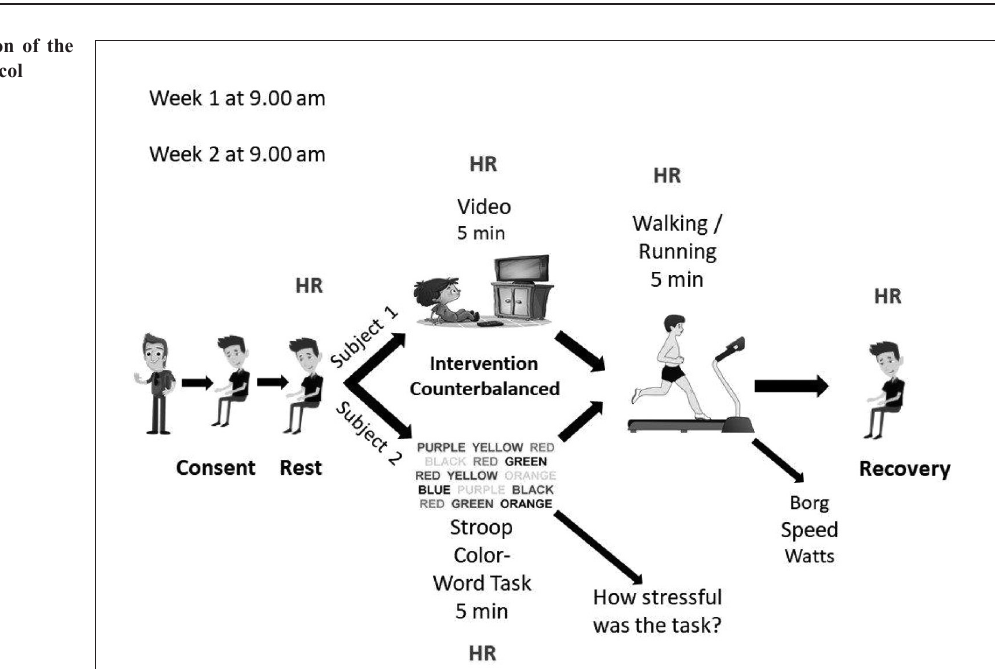
Figure 1. Illustration of the experimental